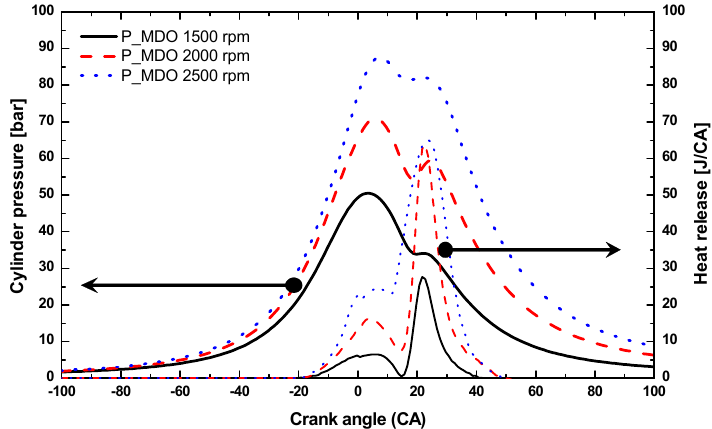
Figure 2. Characteristics of the cylinder pressure and heat release according to rpm for marine diesel oil (MDO). Energies 2018 , 11 , x FOR PEER REVIEW